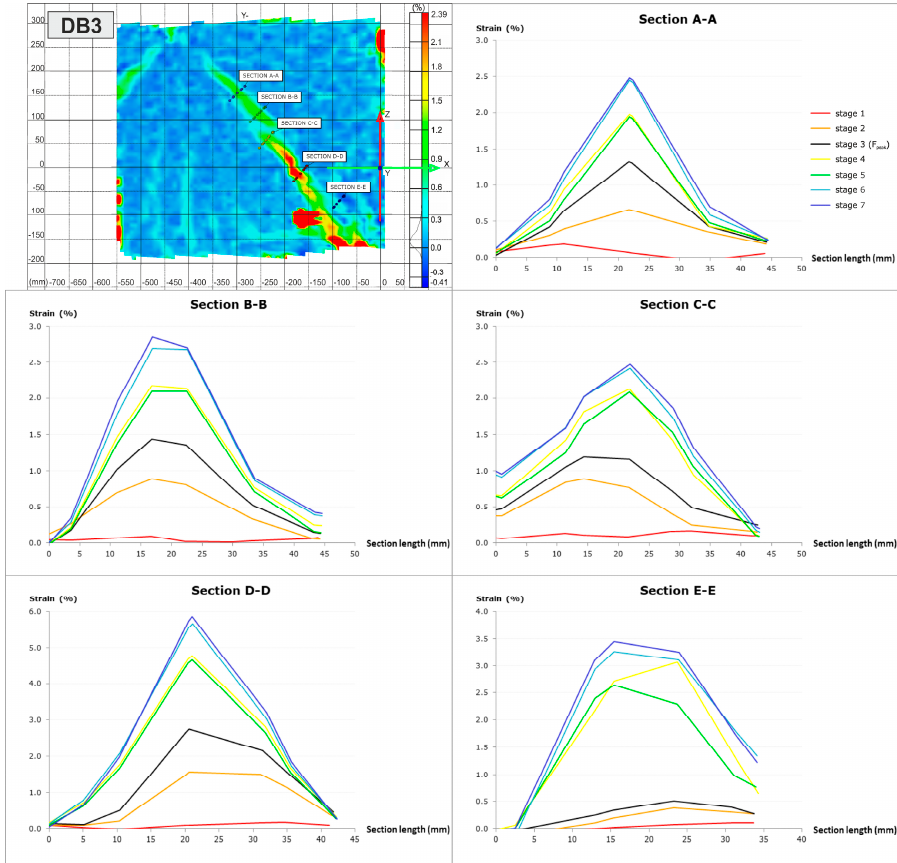
Figure 12. Strains in sections crossing diagonal crack of concrete deep beam (DB1) and hybrid fibre- reinforced concrete deep beams (DB2, DB3). fibre-reinforced concrete deep beams (DB2,